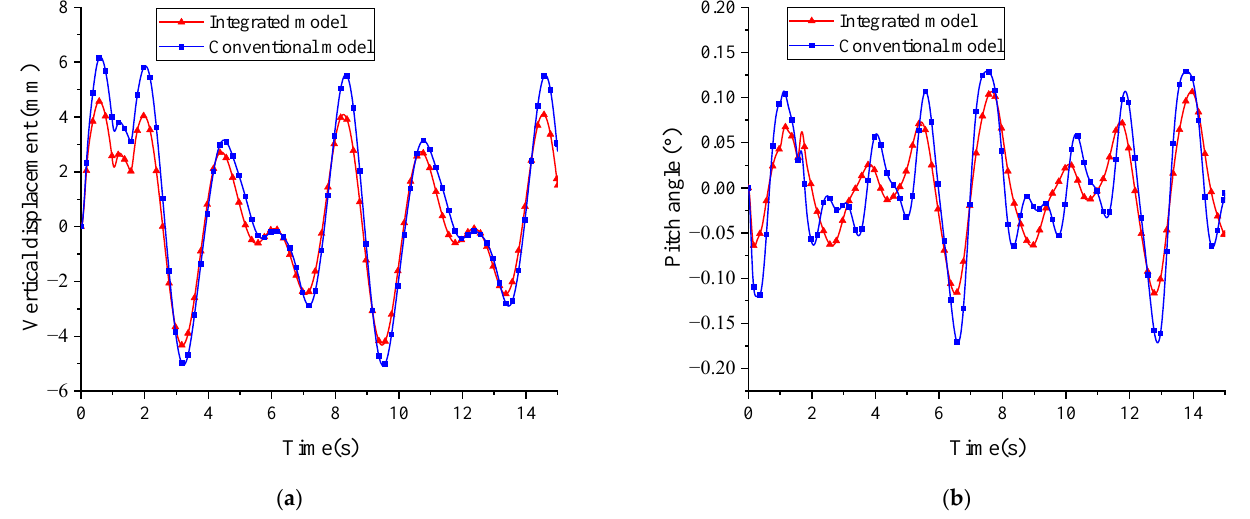
Figure 8. ( a ) Comparison curve of vehicle vertical displacement under sinusoidal signals; ( b ) com- parison curve of vehicle pitch angle under sinusoidal signals.